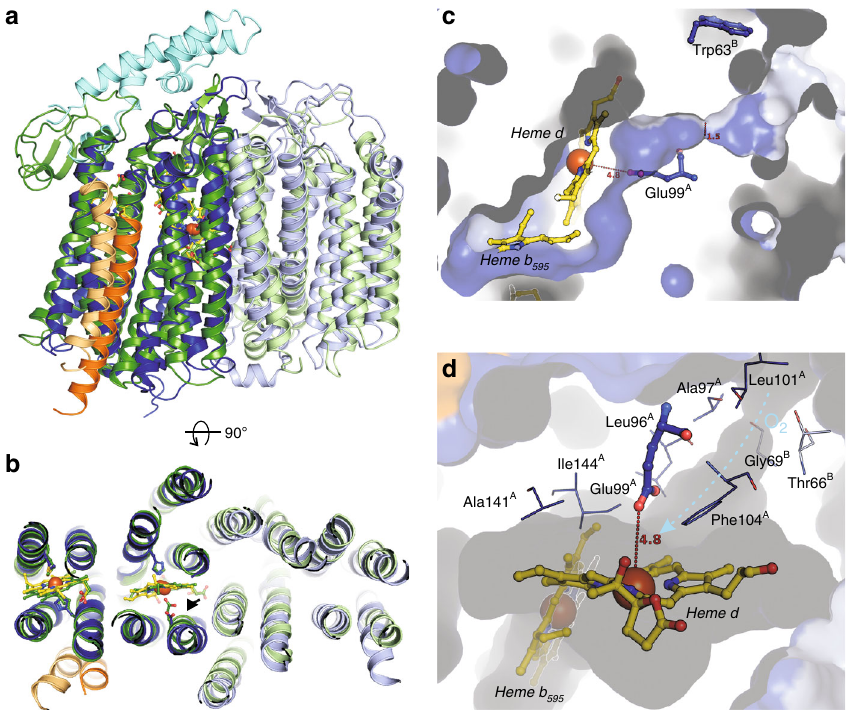
Fig. 2 The heme arrangement in E. coli bd oxidase provides a substrate cavity at heme d. a In comparison with the G. thermodenitri fi cans enzyme (pdb ID 5DOQ, CydA: dark green, CydB: light green, CydS: light orange), the E. coli enzyme features a positional exchange of hemes b 595 and d. b As opposed to b 595 of G. thermodenitri fi cans bd oxidase, the central iron of heme d in the E. coli enzyme does not recruit Glu99 of CydA as axial ligand, leaving a voluminous cavity for substrates (arrow). c CydA (dark blue surface) and CydB (light blue surface) form a channel from the solvent to heme d with maximum constriction to 1.5 Å. The dislocation of Glu99 (CydA) provides space for a small substrate like dioxygen to bind as axial ligand to heme d. d Several hydrophobic residues surround Glu99 A , forming a hydrophobic roof above the cavity harboring heme d. The putative oxygen channel shown in ( c ) is indicated with an ice blue arrow. The constriction of this channel is formed by hydrophobic moieties of both CydA (Ala97 and Leu101) and CydB (Thr66 and